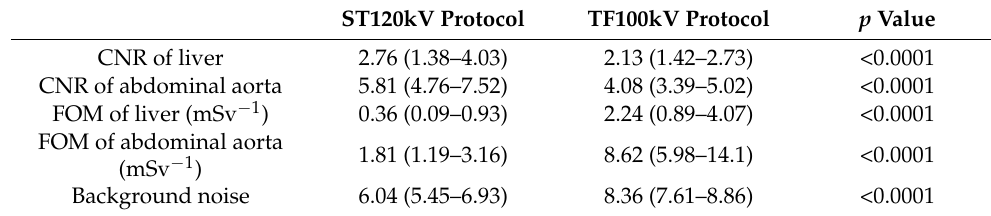
Table 4. Objective assessment of image